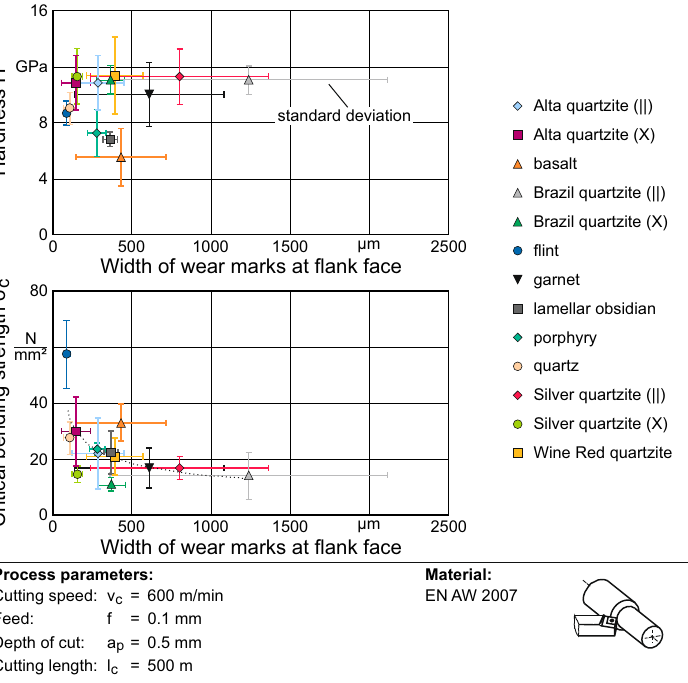
Fig. 19 Influence of hardness and critical bending strength on